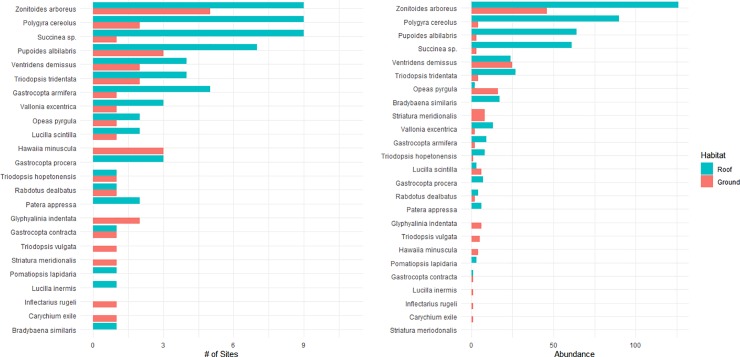
Snail diversity summarizing number of green roof sites found and total abundance.